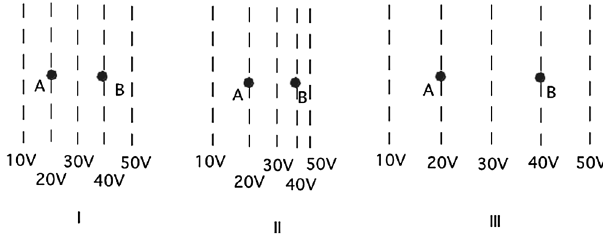
FIG. 5. Diagram provided for Q17 – Q19 on the